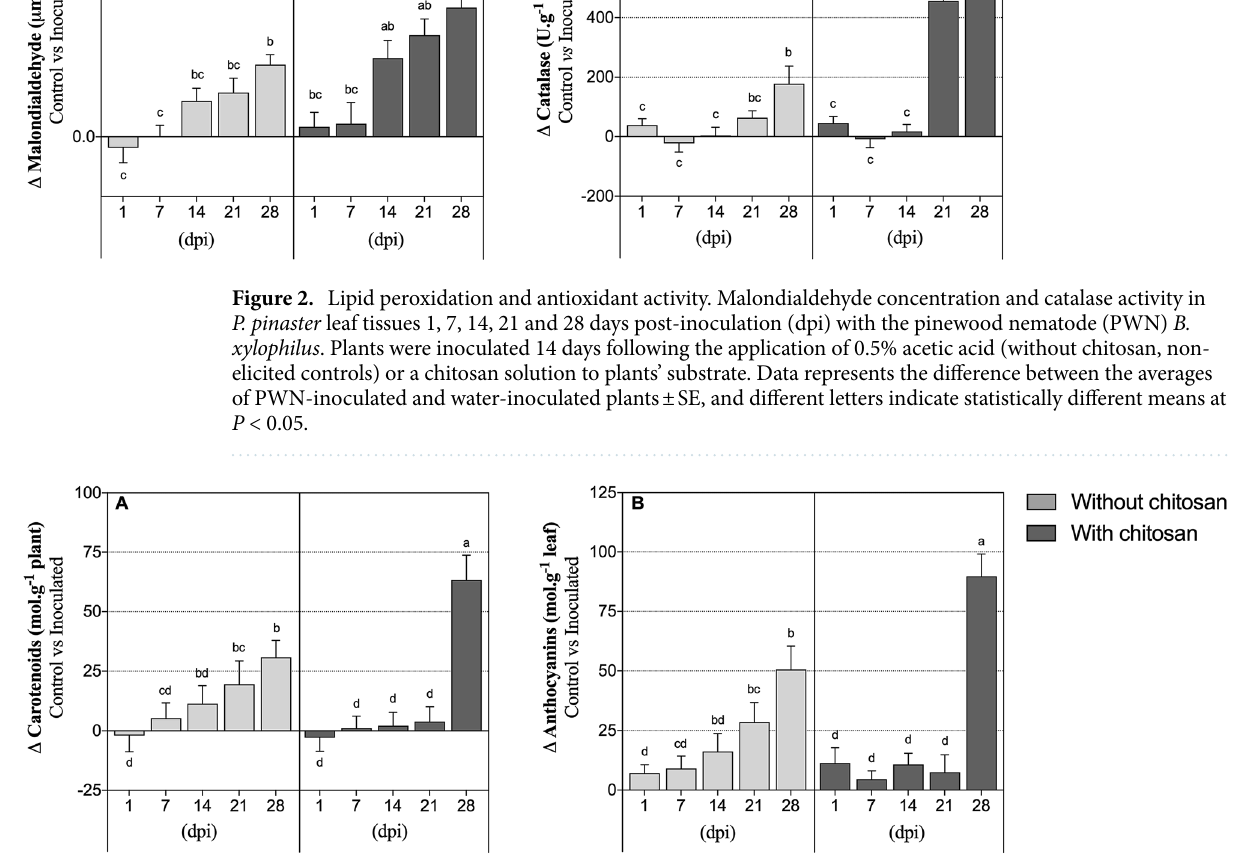
Figure 3. Carotenoids and anthocyanins. Carotenoids and anthocyanins concentrations in P. pinaster leaf tissues 1, 7, 14, 21 and 28 days post-inoculation (dpi) with the pinewood nematode (PWN) B. xylophilus . Plants were inoculated 14 days following the application of 0.5% acetic acid (without chitosan, non-elicited controls) or a chitosan solution to plants’ substrate. Data represents the difference between the averages of PWN-inoculated and water-inoculated plants ± SE, and different letters indicate statistically different means at P < 0.05.